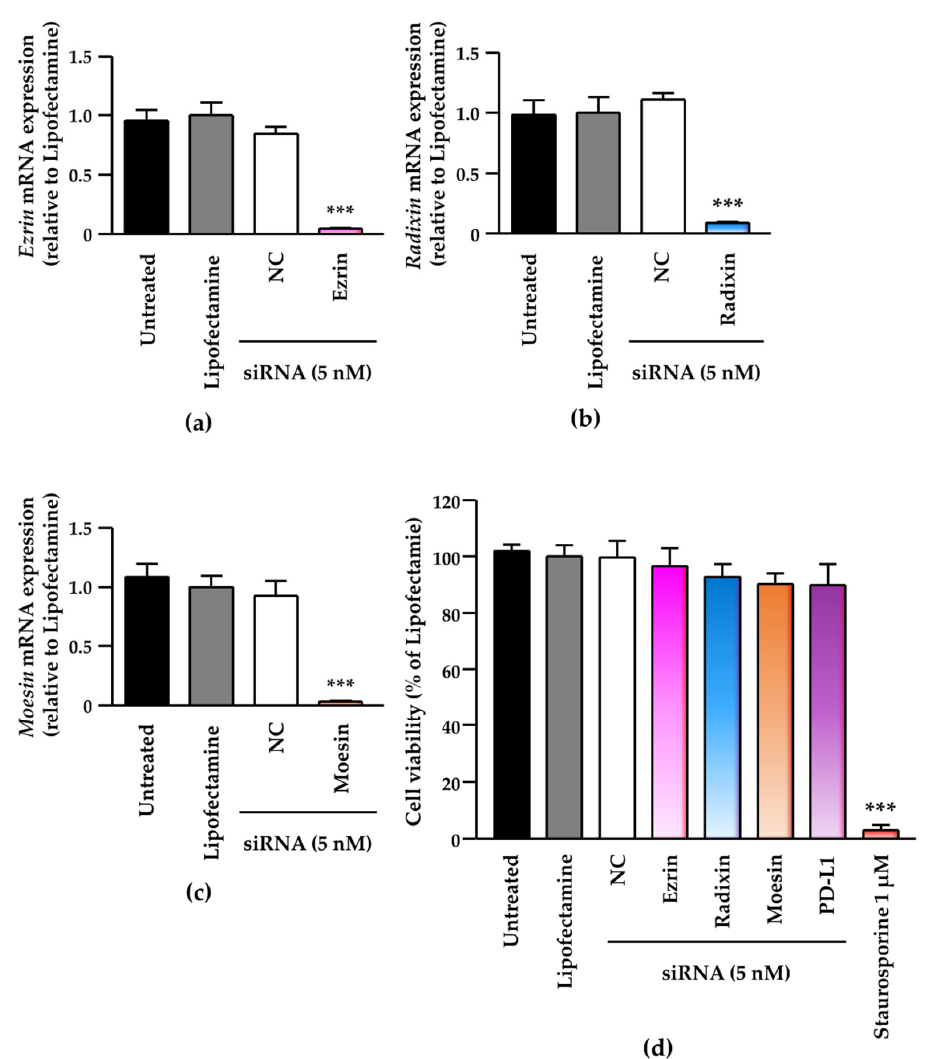
Figure 4. Effects of small interfering (si) RNA-mediated knockdown of the ERM family on target mRNA levels and cell viability in BOKU cells. Cells were treated with transfection medium (Untreated), transfection reagent (Lipofectamine), nontargeting control (NC) siRNA, or specific siRNAs for ezrin, radixin, or moesin at 5 nM, and then cultured for four days. Each column shows the mRNA level of ( a ) ezrin, ( b ) radixin, and ( c ) moesin normalized to β -actin in cells from each treatment group relative to that in cells treated with Lipofectamine alone, as determined by RT-PCR. n = 3, *** p < 0.001 vs. Lipofectamine. All data are expressed as the mean ± standard of the mean (SEM) and were analyzed by one-way analysis of variance (ANOVA) followed by Dunnett’s test. ( d ) Cell viability of BOKU cells. n = 6, *** p < 0.001 vs. Lipofectamine. All data are expressed as the mean ± SEM and were analyzed by one-way ANOVA followed by Dunnett’s test.